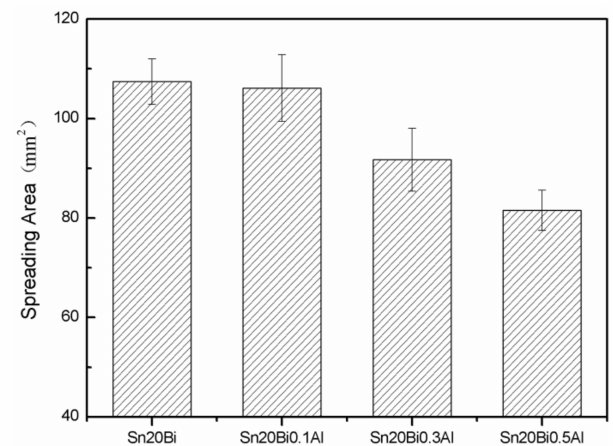
Figure 6. Spreading area of Sn-20Bi-xAl solder alloy.